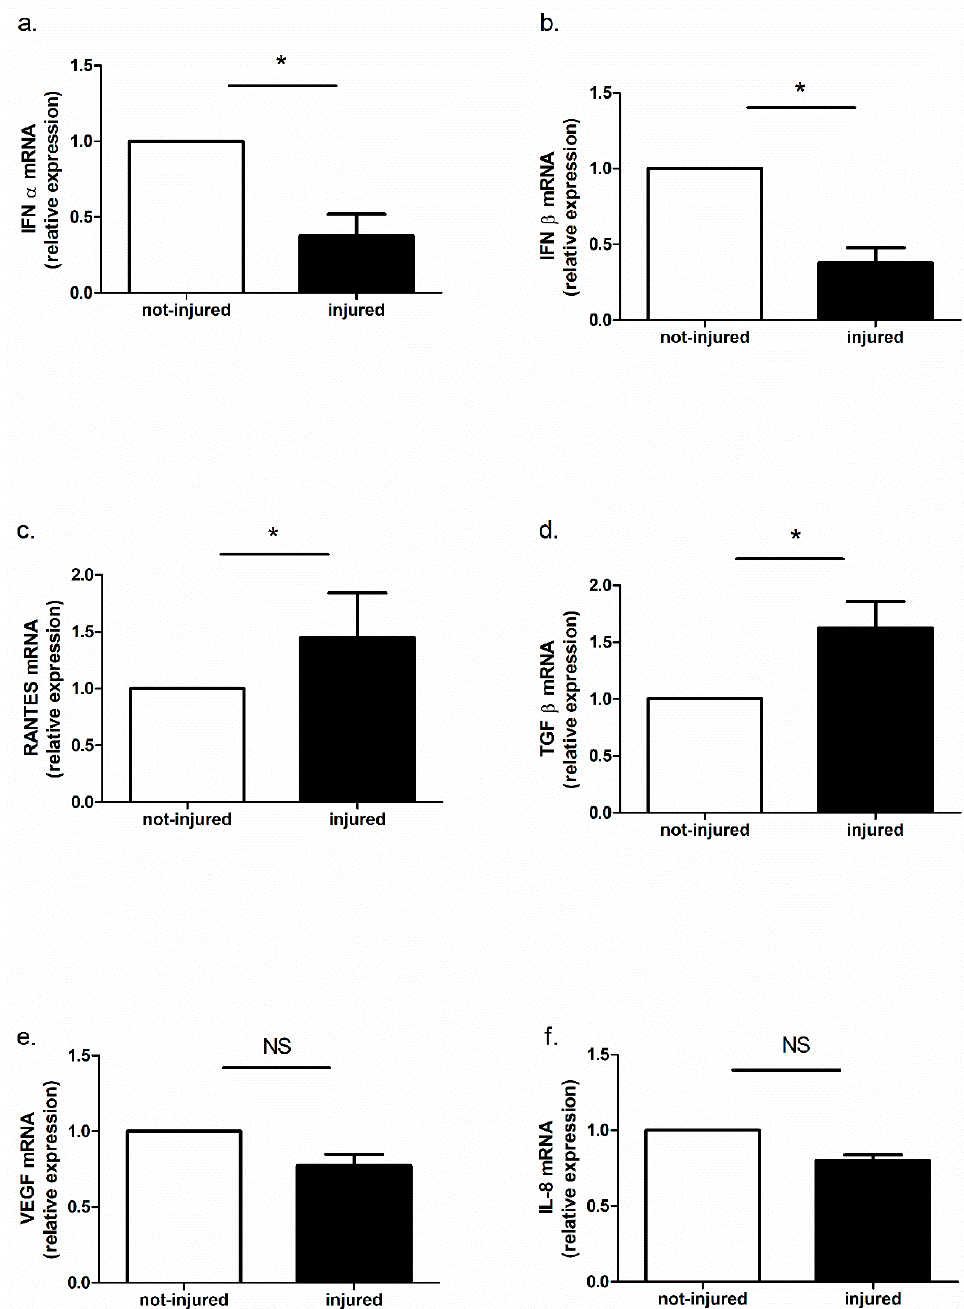
Figure 8. Cytokines mRNA expression in wounded and not-wounded epithelial cells. ( a ) IFN- α ; ( b ) IFN- β ; ( c ) RANTES; ( d ) TGF- β ; ( e ) VEGF; ( f ) IL-8; * p < 0.05; NS: no statistically significant difference. LPS stimulation decreased IFN- α and IFN- β mRNA expression in both not-injured and injured BEAS-2B cell cultures. LPS did not affect RANTES, TGF- β , VEGF, and IL-8 mRNA expression either in wounded or in not-wounded cells.